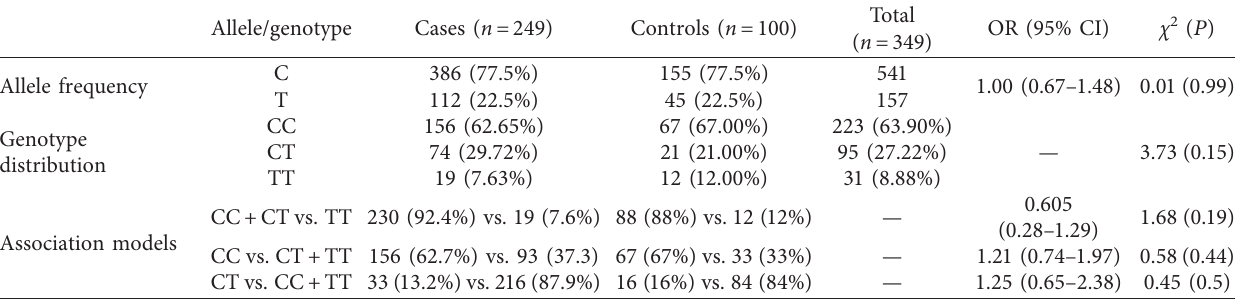
Table 1: Comparison of allele frequency, genotype distribution, and genotype association models of INSR exon 17 C/T SNP in PCOS and control women.